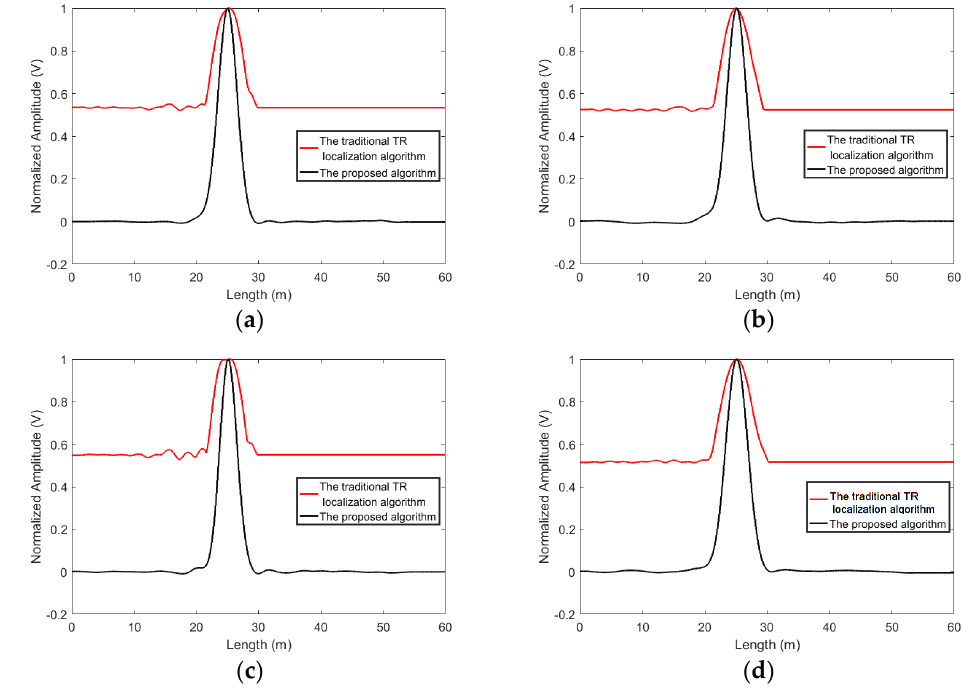
Figure 5. The four extra experiment results obtained by using the proposed algorithm and the traditional time reversal localization algorithm for Leakage 1, ( a ) Data 1, ( b ) Data 2, ( c ) Data 3, ( d ) Data 4.